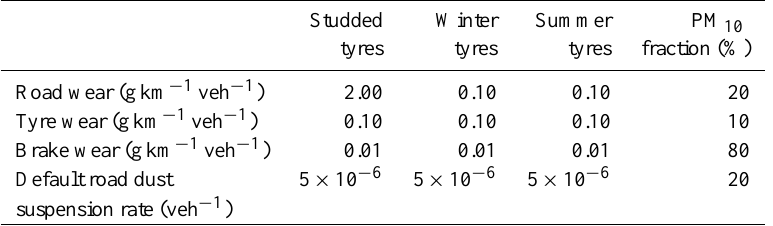
Table 1. Values of parameters used in the NORTRIP model in this study. The values of the wear rates, separately for road, tyres and brakes, and road dust suspension rates are presented for studded, winter and summer tyres. The term PM 10 fraction refers to the fraction of wear and suspension particles in the size range less than 10µm of all particles for light-duty vehicles used in the NORTRIP model calculations. The PM 10 fraction is the same for all vehicles. Wear and suspension rates for heavy-duty vehicles are considered to be 5 and 10 times larger, respectively, compared with light-duty vehicles. The reference speed for all of these parameters is 50kmh − 1